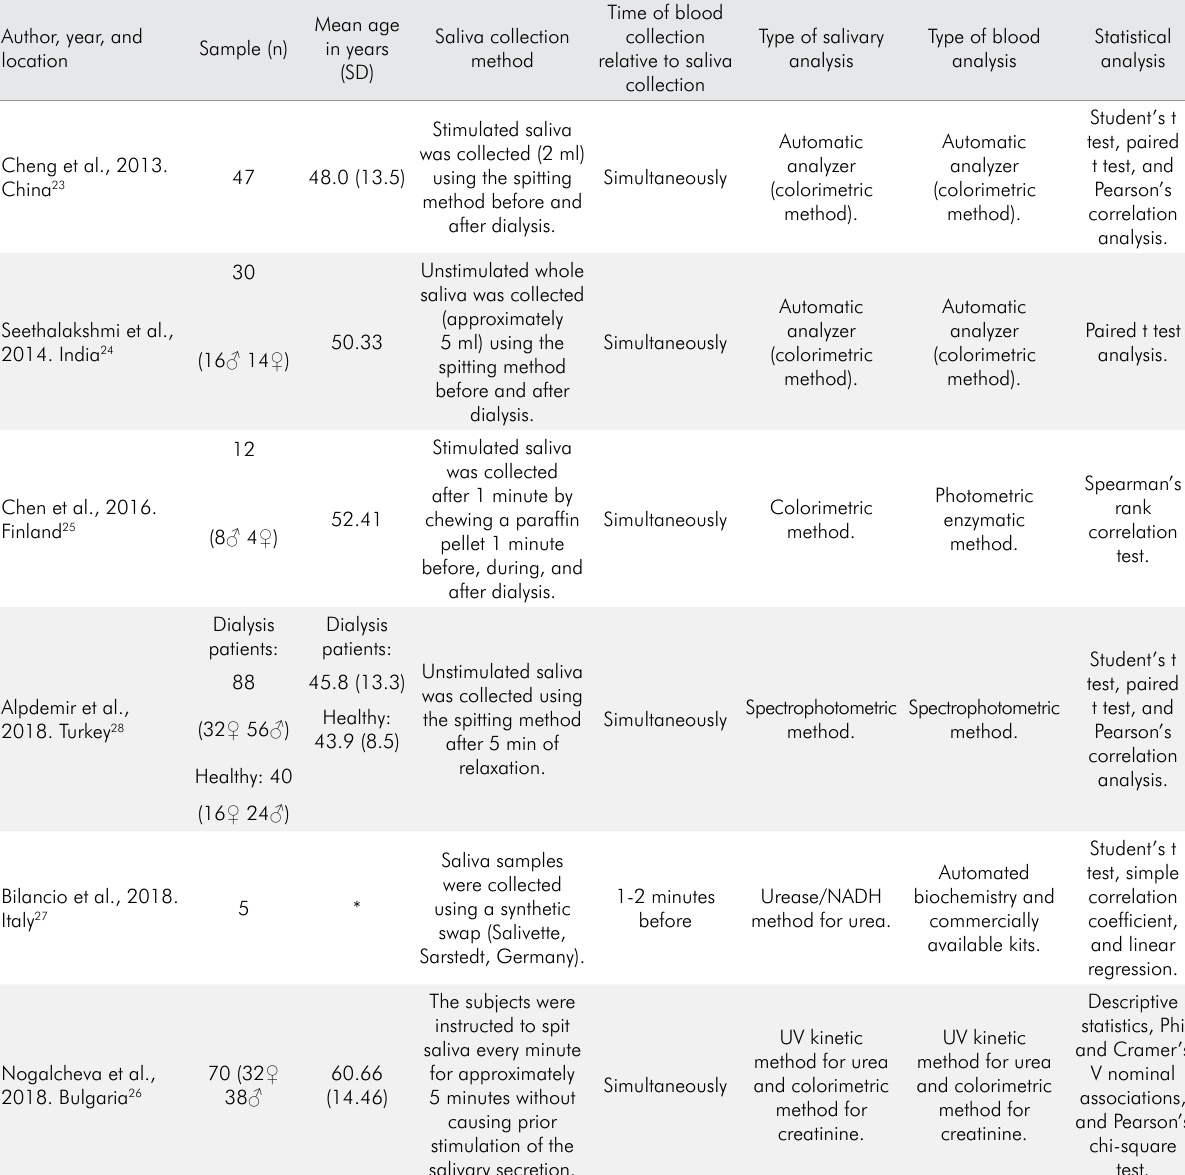
Table 2. Summary of the main characteristics of the eligible